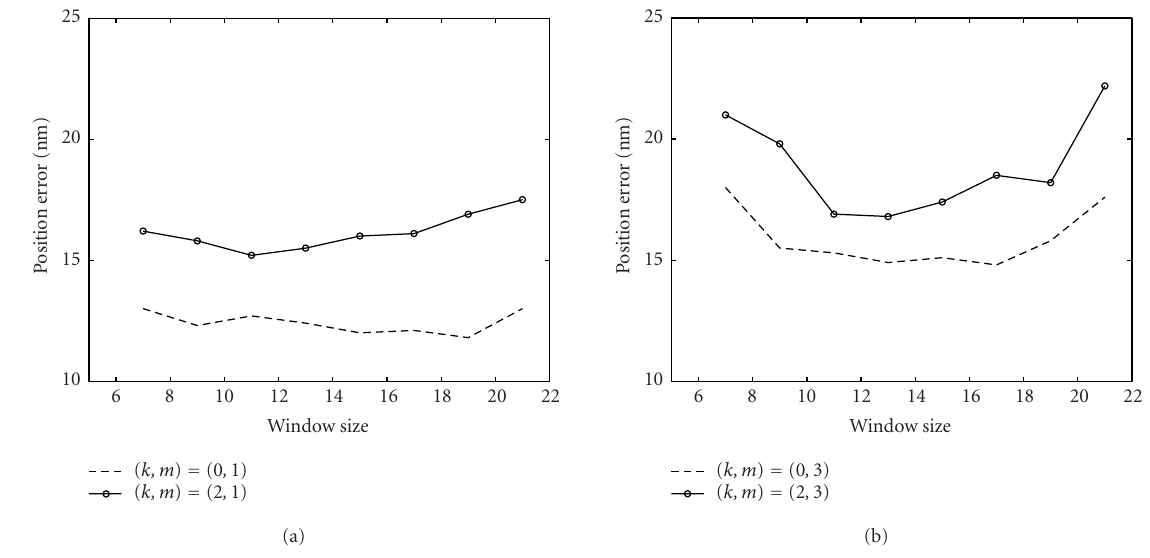
Figure 6: Position error for a Gaussian envelope: (a) ( k , m ) = (0,1), ( k , m ) = (2,1) and (b) ( k , m ) = (0,3), ( k , m ) =